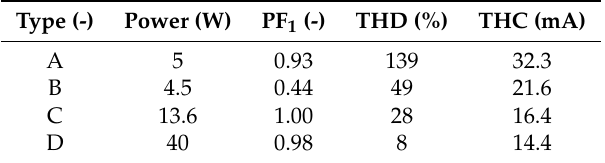
Figure 2. Line current waveforms of the LED lamps at rated sinuosoidal voltage, where each lamp is normalized with respect to its true rms value. Table 1. Main electrical data of the considered LED lamps at rated sinusoidal voltage. PF 1 = fundamental power factor; THD = total harmonic distortion; THC = total harmonic